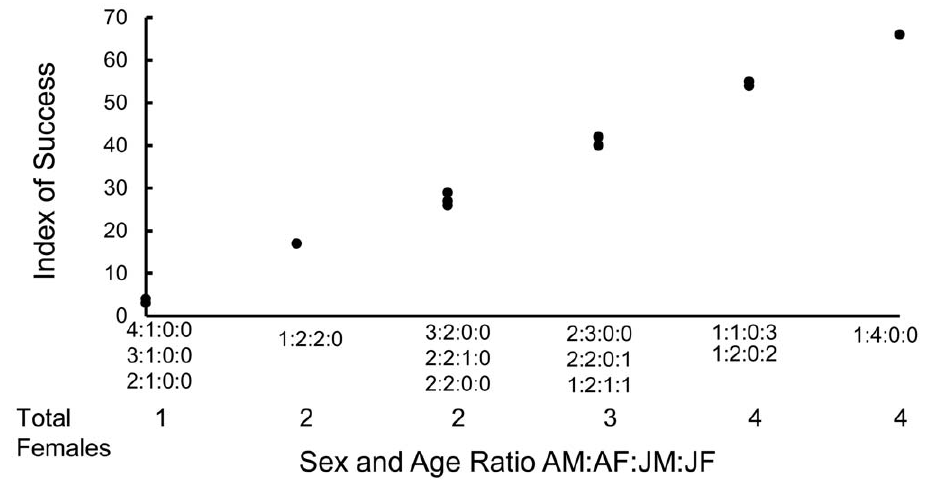
Figure 3. Predicted relationship between numbers of female and male fishers released, including juveniles, and reintroduction success. Fishers were released at each of 4 subsites in each of 5 years. The VORTEX model included stochastic variation and was run for 100 years. Twenty fishers were modeled to be released each of 5 years in 4 groups of 5, with each group released into a different site.